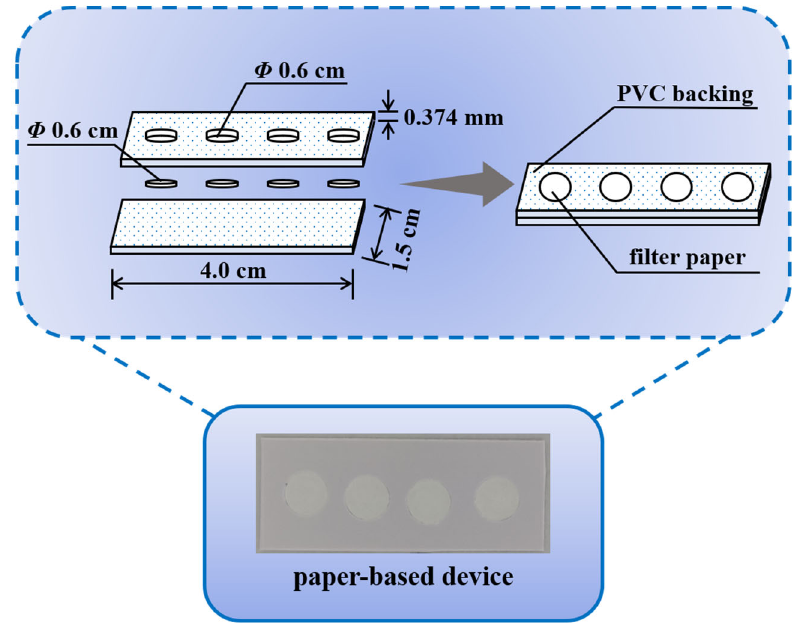
Figure 1. Structure diagram of the paper ‐ based device.